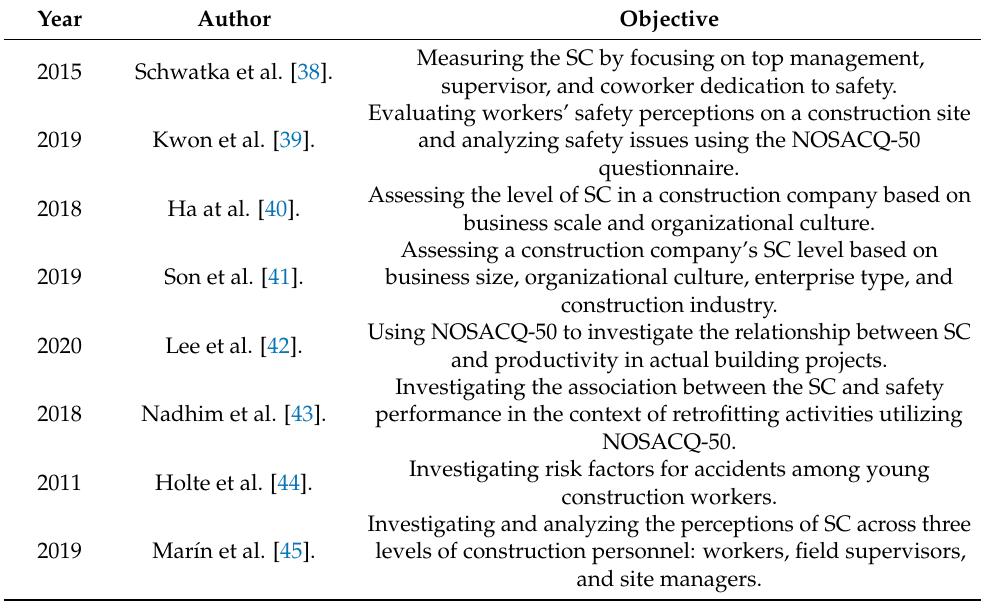
Table 1. Summary of previous research that has used NOSACQ-50 in assessing SC in the construction